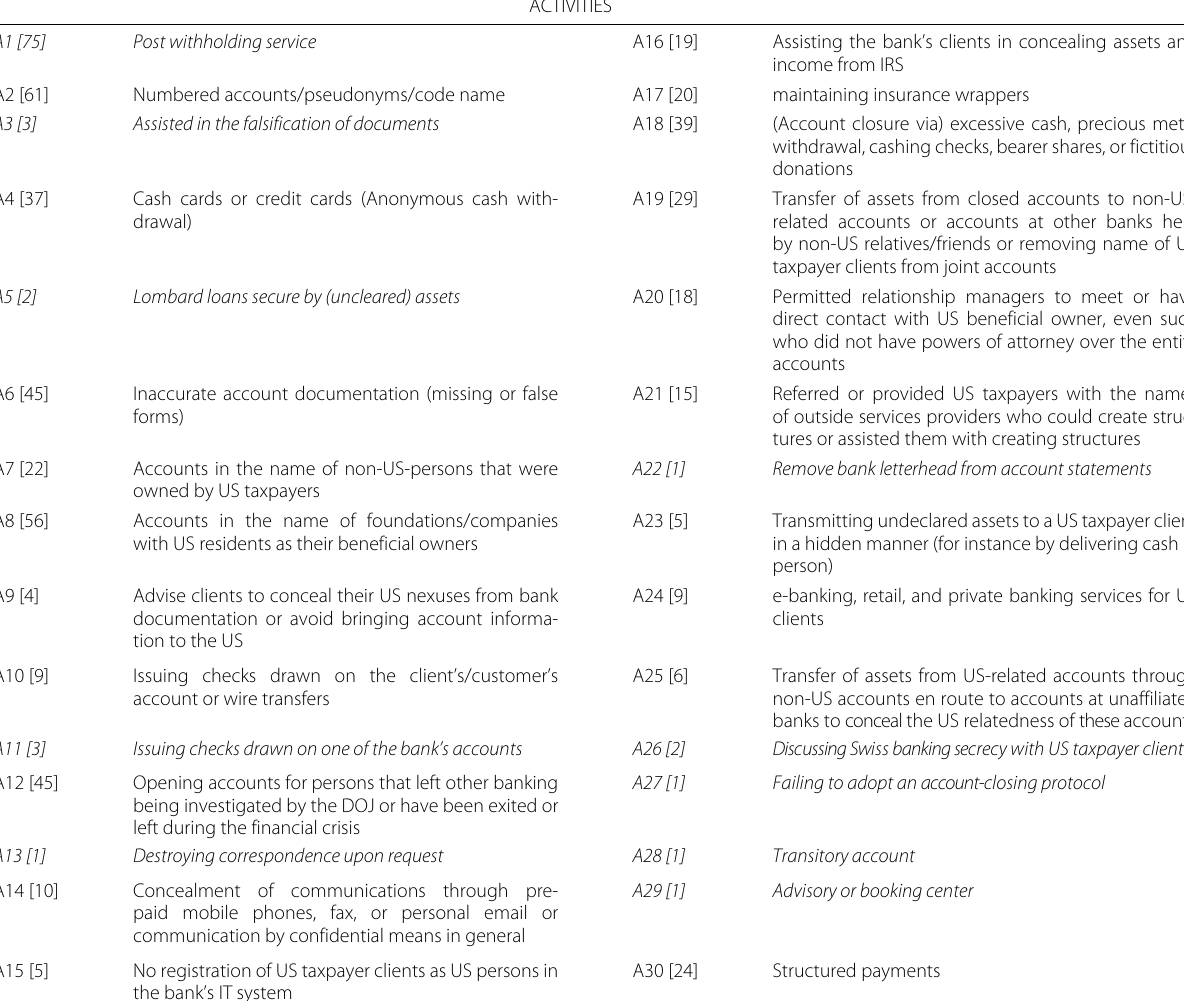
Table 1 Activities of banks as described by the